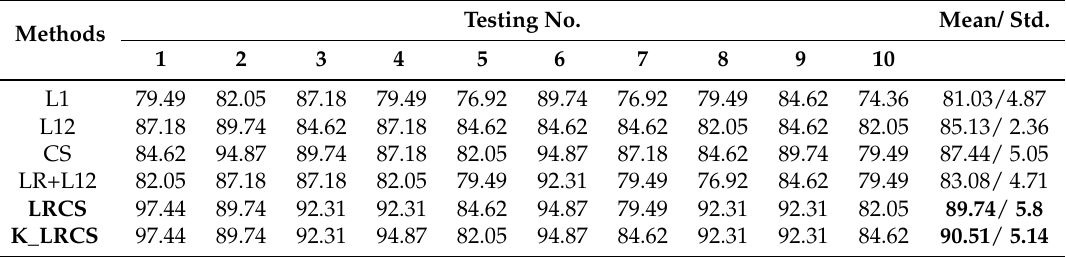
Table 4. Recognition rates (%) of various joint representation models on Maryland dataset. Testing No. Mean/ Methods